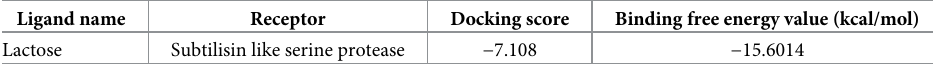
Table 4. Final docking score and binding free energy values of lactose against CAASPR-HM49 subtilisin like protease.